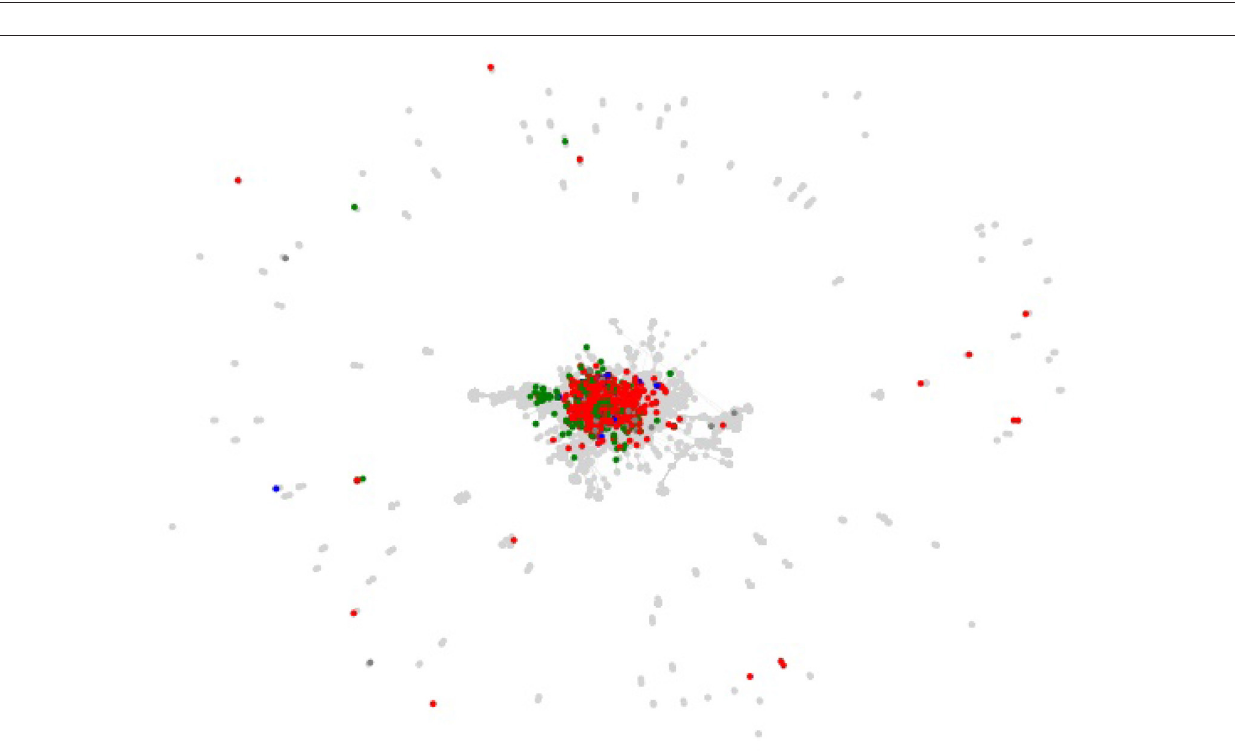
FIGURE 4 | Overlap of the virus-host protein–protein interaction databases for the Influenza A virus.